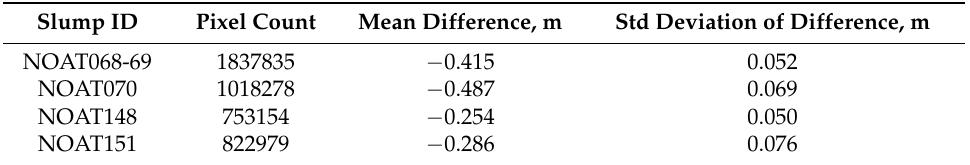
Table 1. Statistics for difference between 2013 and 2016 DEMs in a buffer zone outside the slump 1